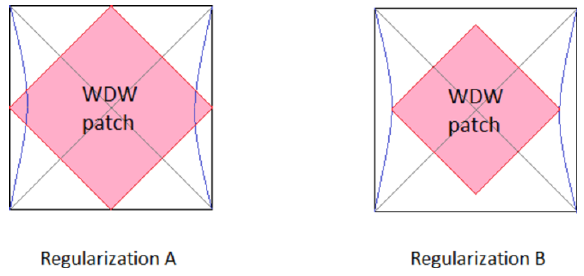
Figure 1 . The two regularizations commonly used in the CA conjecture.